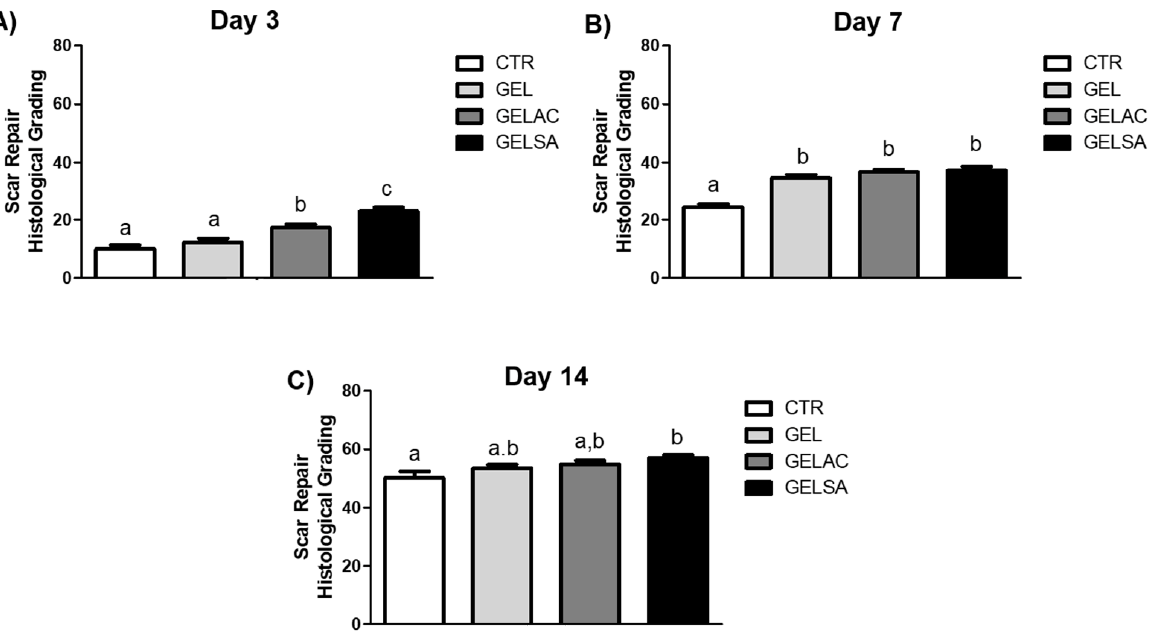
Figure 14. Mean scores of the evolutionary profile of the wound repair process in rats submitted to treatment with biomembranes containing SA extract and AC extract, on ( A ) day 3, ( B ) day 7 and ( C ) day 14. Data expressed as mean ± standard error of the mean. Equal letters represent no significant difference ( p > 0.05), different letters represent significant difference p < 0.001.